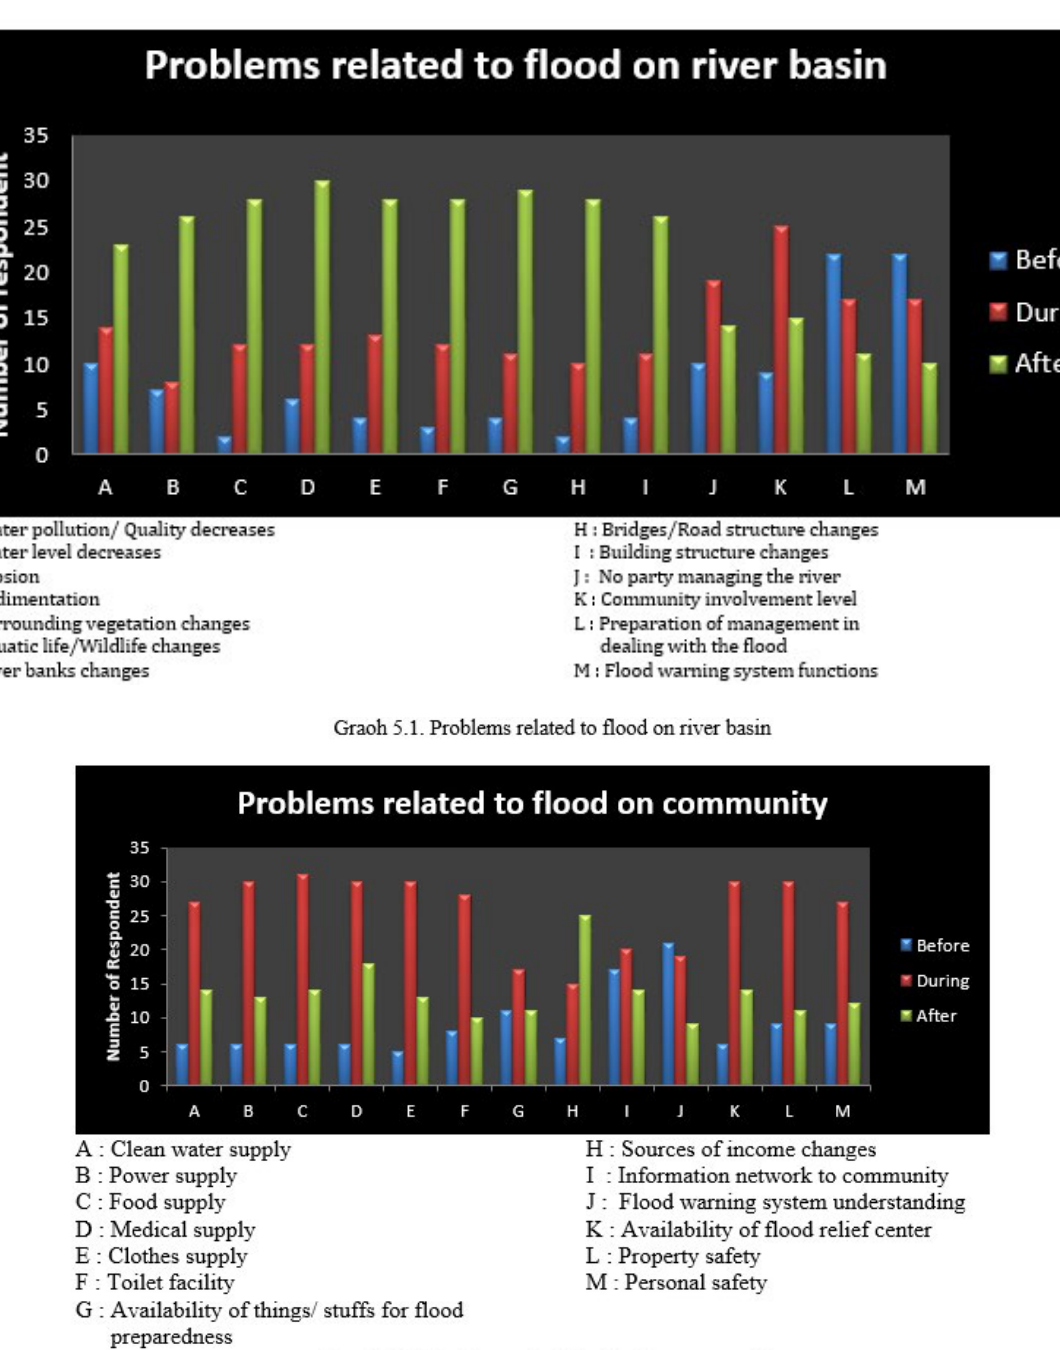
Figure 5 Location on the stereonet of wedge weight, W; the normal Ni, NA and NB and angle to the normal, βi (δi), δA and δB (Kliche, 1999). The resisting force on plane A and B according to Mohr-Coulomb